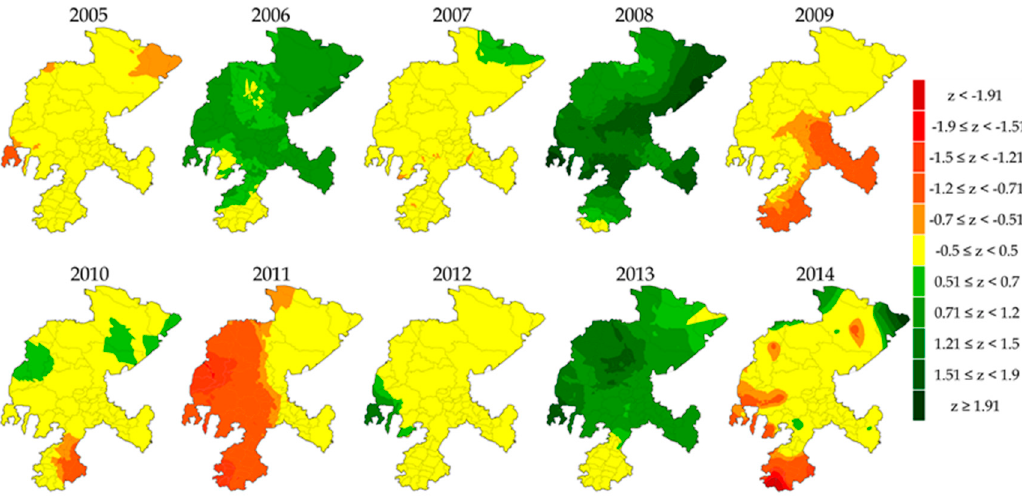
Figure A2. Three ‐ month timescale Reconnaissance Drought Index (July–September).